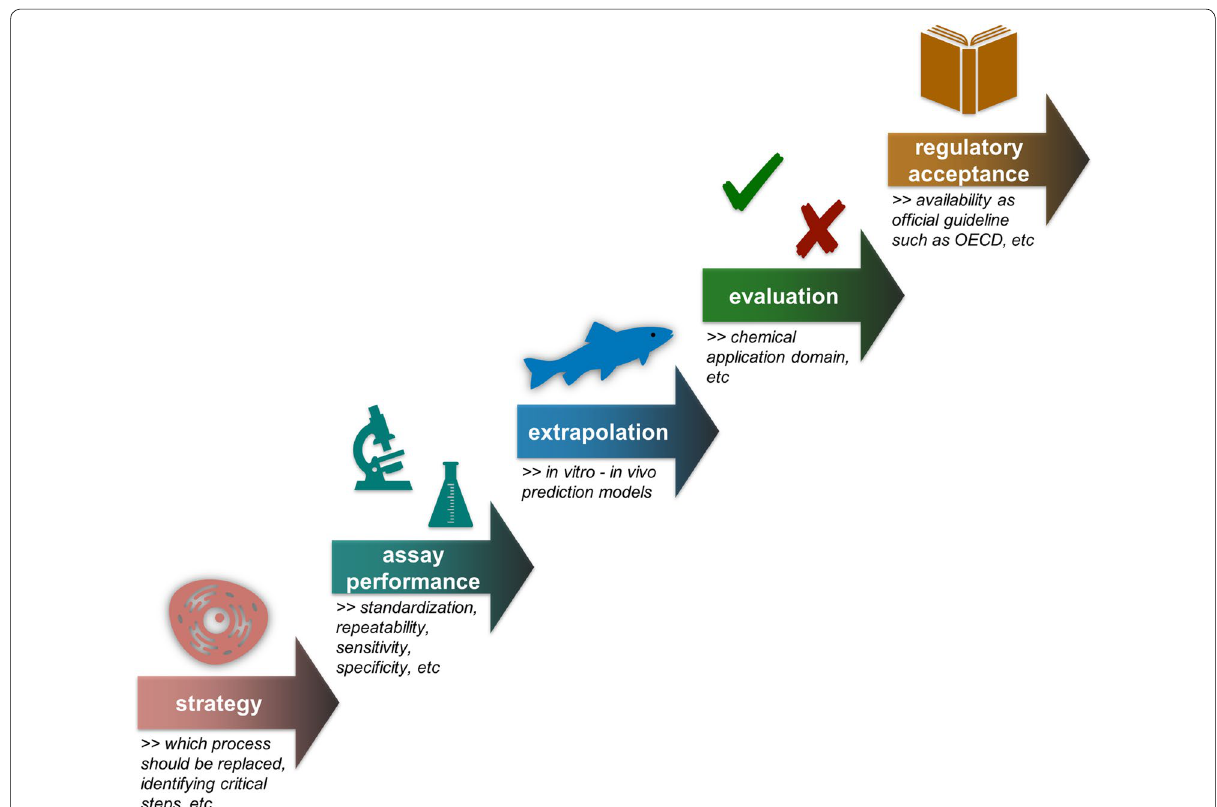
Fig. 2 Crucial steps for developing and implementation of in vitro assays as an alternative for in vivo tests: First, steps and processes need to be defined in order to find out which target process could be replaced by in vitro assays. Next, assay performances including aspects such as test standardization have to be optimized, and it needs the development of appropriate in vitro–in vivo extrapolation models. Finally, the chemical application domain of the in vitro assays has to be identified. The last step, which is important for regulatory acceptance, is the implementation of an official Test Guideline, like the OECD Test